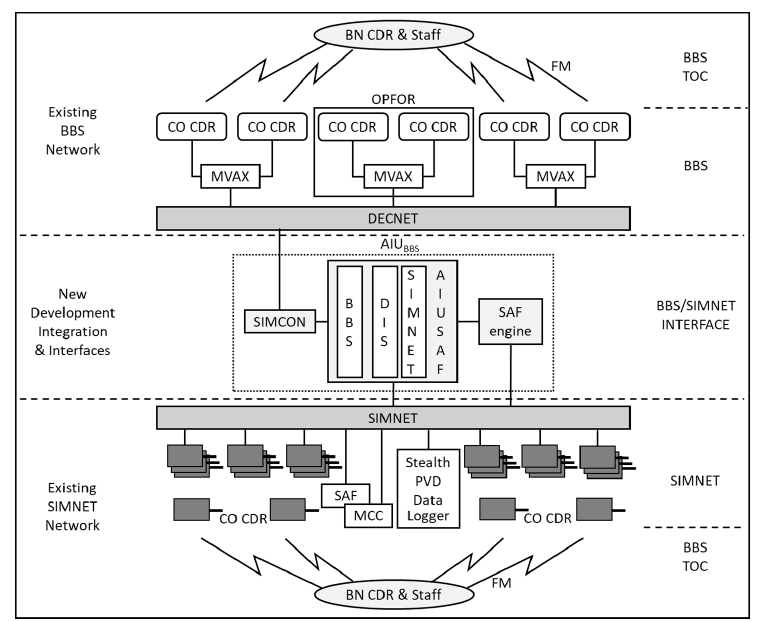
Figure 7. The architecture for the BBS/SIMNET integration in Europe (adapted from [36]).